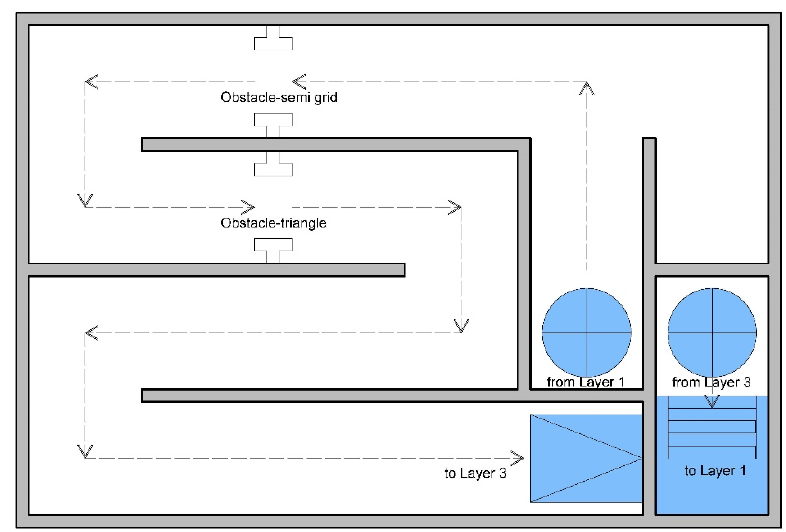
Figure 4. Floor plan for Layer 2.